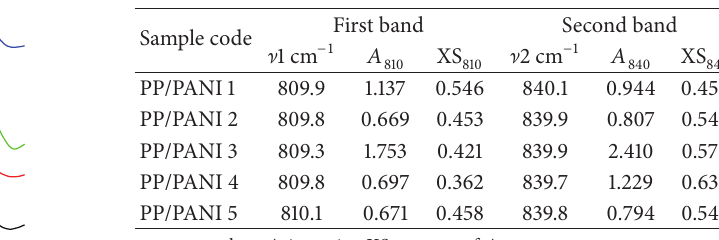
Table 2: Curve-fitting results for spectra of the region (780– 856 cm − 1